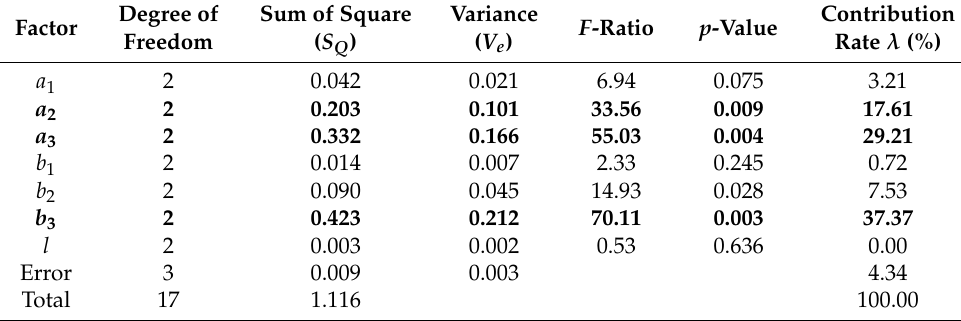
Table 7. ANOVA for 800